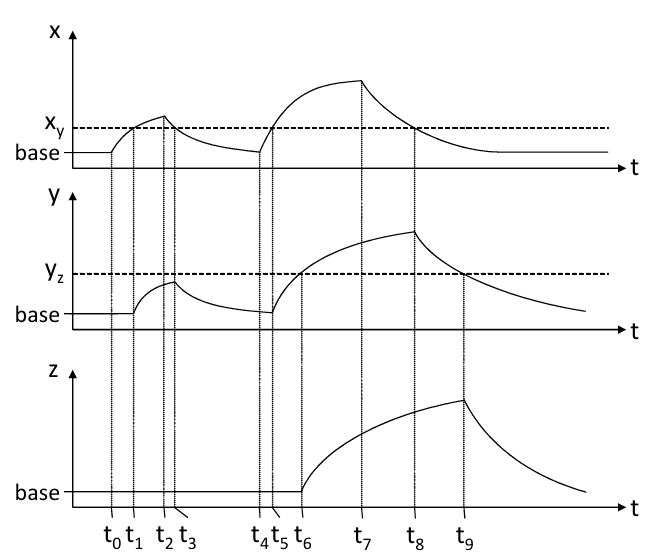
Figure 3: Simple ex- ample.